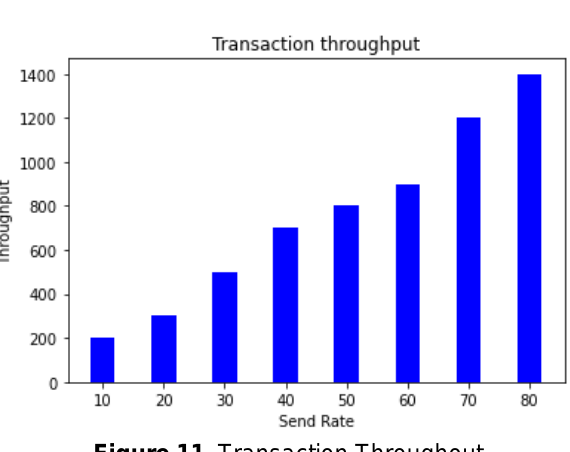
Figure 10. Read Transaction Throughout